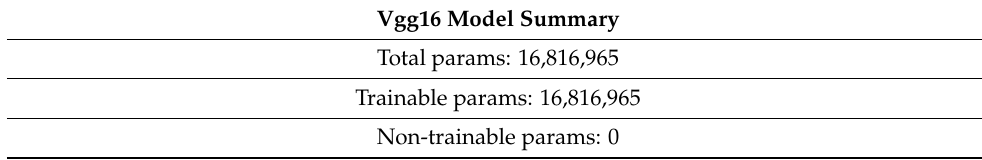
Table 1. Vgg16 model summary.